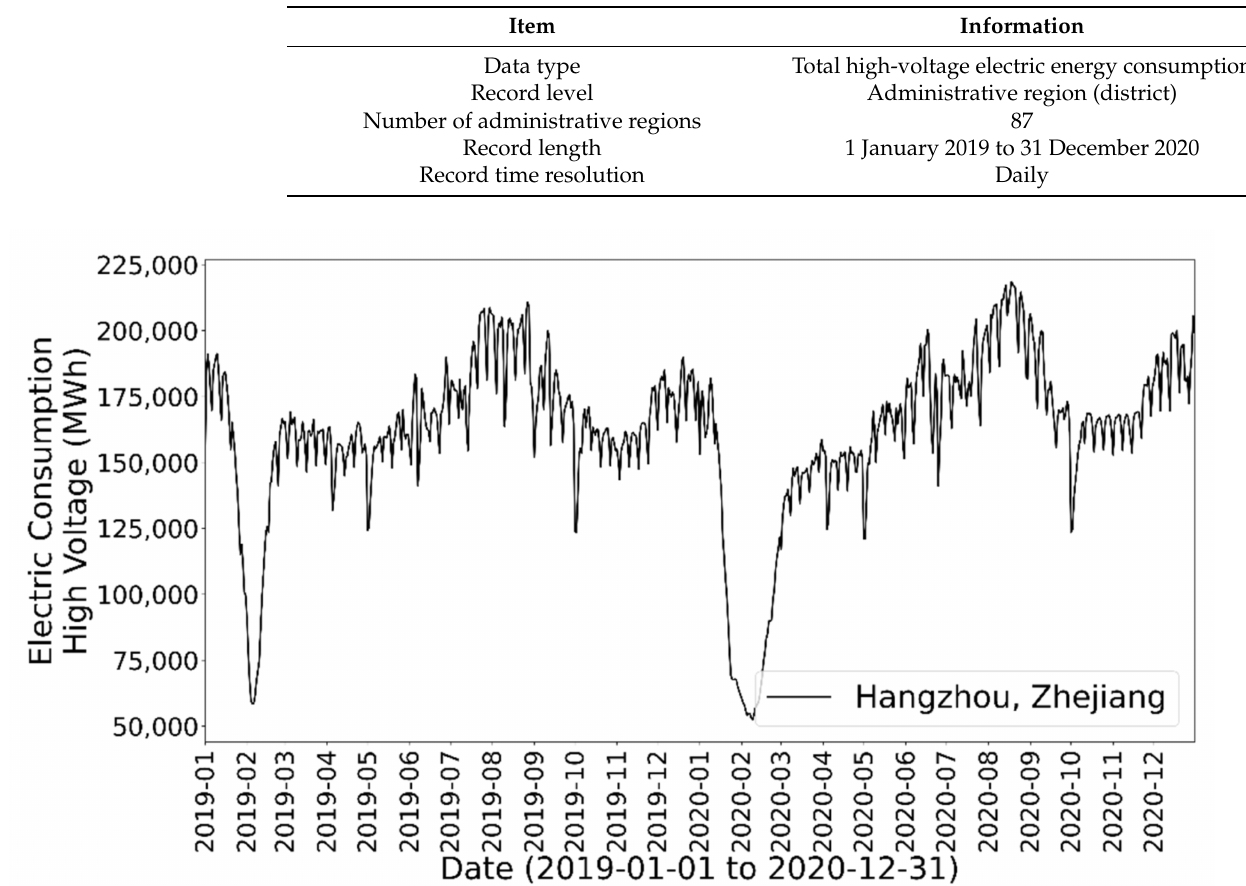
Table 1. Basic information of the electricity consumption data used in this study.